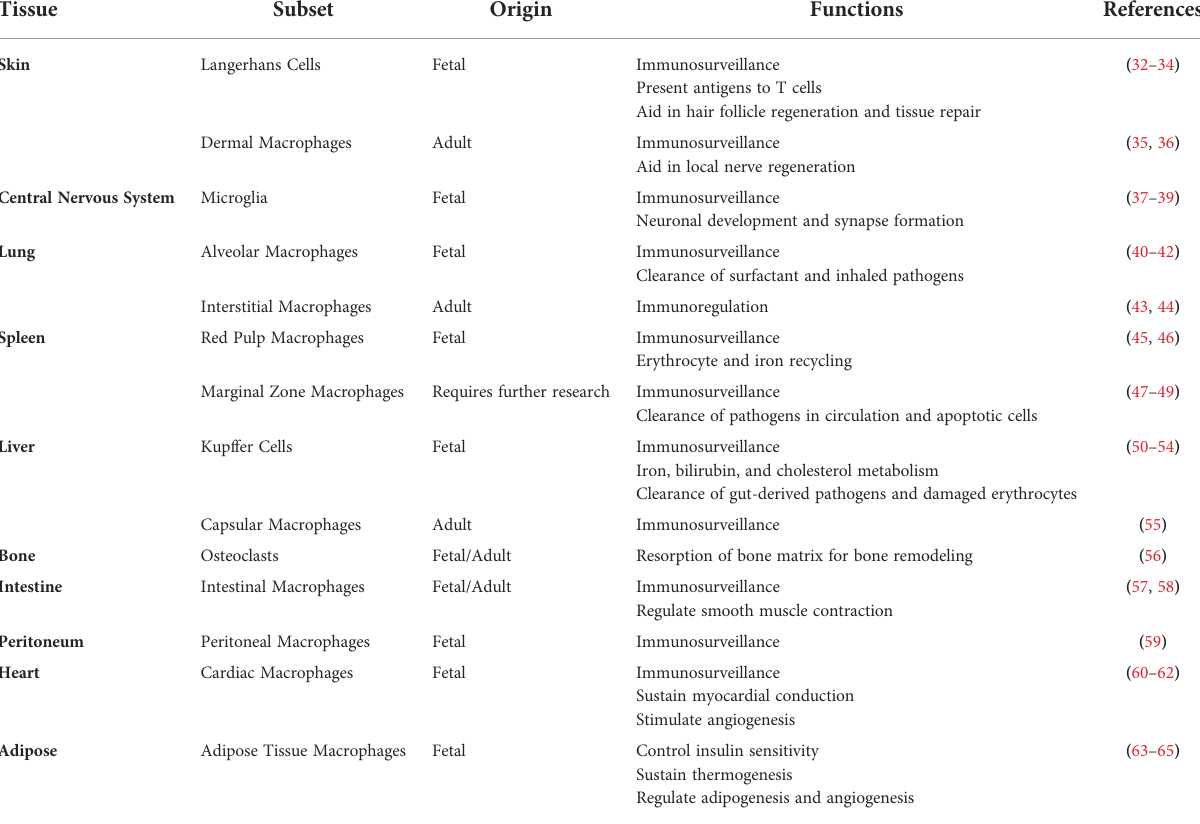
TABLE 1 Summary of tissue-resident macrophage subsets, origins, and functions. Tissue Subset